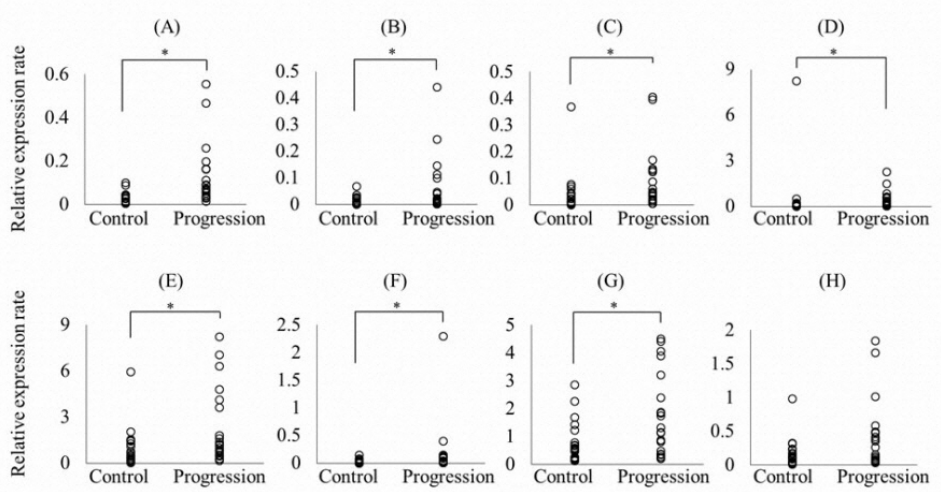
Figure 2. Relative expression rates of hsa-miR-5571-5p ( A ), hsa-miR-17-3p ( B ), hsa-let-7f-5p ( C ), hsa-miR-99a-5p ( D ), hsa-miR-200a-3p ( E ), hsa-miR-28-5p ( F ), hsa-miR-320d ( G ), and hsa-miR-31-5p ( H ) in saliva using quantitative real-time PCR assays. The relative expression rate of each miRNA was normalized to that of U6 snRNA. Each individual sample is shown as a circle ( n = 22/group). * p < 0.05, Mann–Whitney U -test.